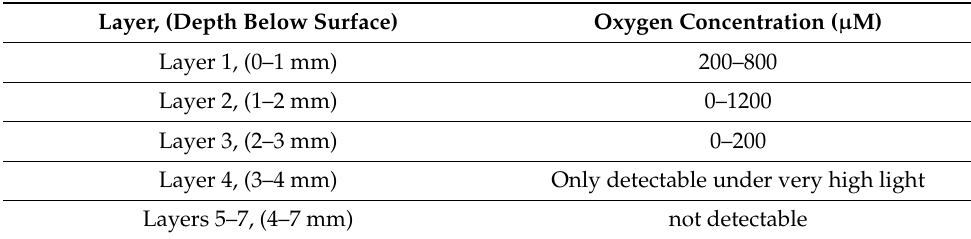
Table 1. Ranges of oxygen concentration in hypersaline microbial mat from different depths. The depths shown are Layer 1 (0–1 mm from surface), Layer 2 (1–2 mm from surface), Layer 3 (2–3 mm